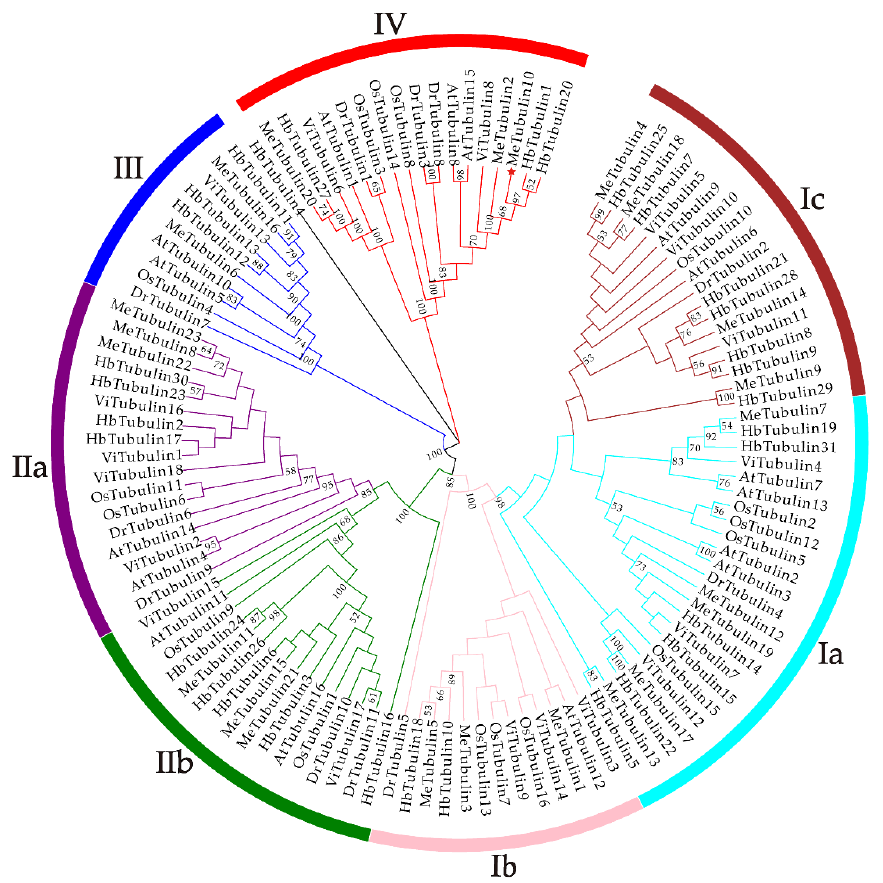
Figure 1. The phylogenetic tree represents the relationship between tubulin proteins in six species. The bootstrap values of less than 50% were hidden. The different-colored arcs and roman numerals indicate different groups (or subgroups) of tubulin proteins. The red star (MeTubulin10) represent FtsZ2-1 from cassava. The branch length values are shown in Supplementary Figure